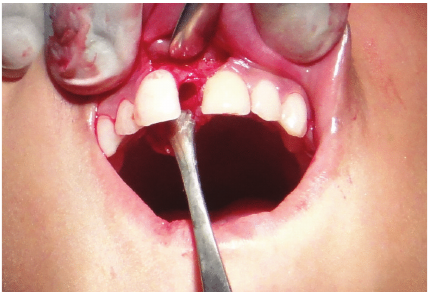
Figure 4: Cavitary space in the nasopalatine region after the granulomatous tissue was curetted